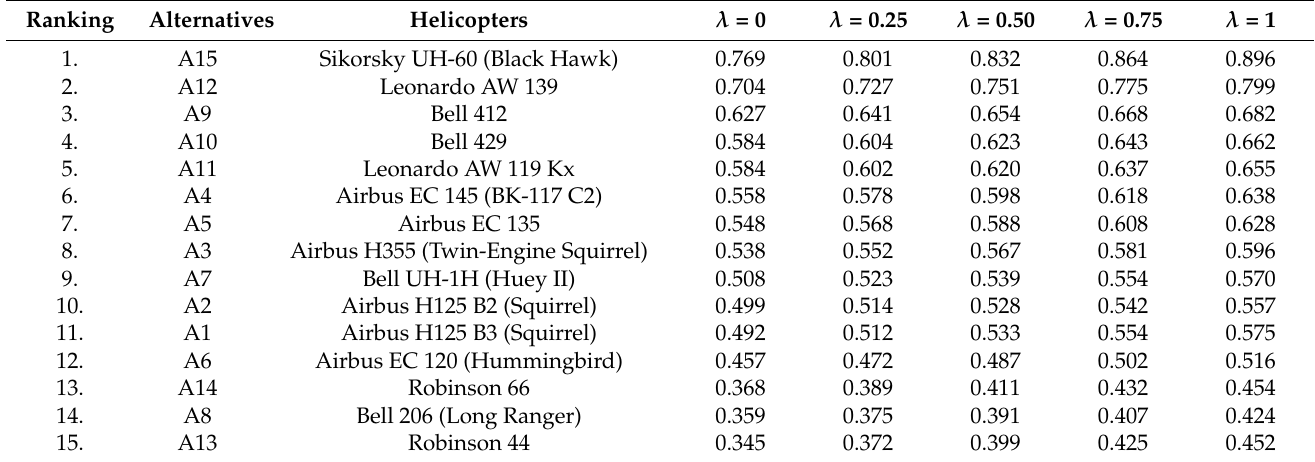
Table 7. The overall ranking of the alternatives.